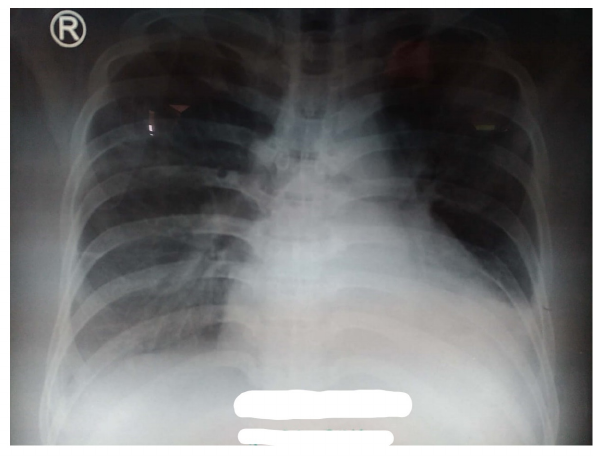
Figure 2. Chest X-ray of the